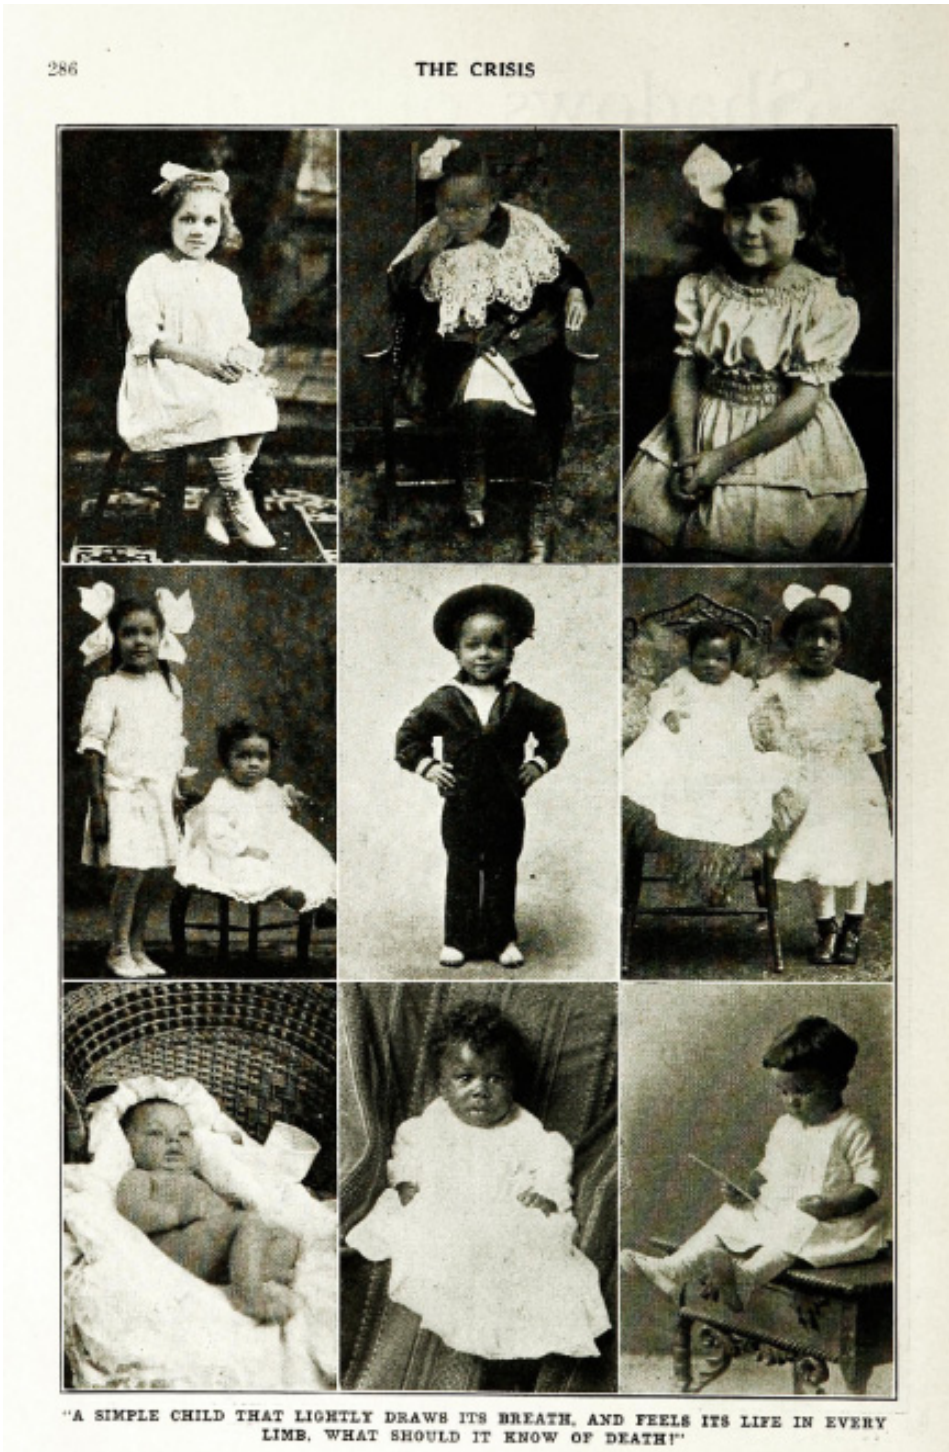
Figure 1. Sample pages from the 1916 Children’s Number’s “Shadows of Light” column, a recurring section that features numerous such grids of photographs of children. ( The Crisis 1916, 12.6, pp. 285– 86), The Modernist Journals Project, https://modjourn.org/issue/bdr510140/, (accessed on 4 Decem- ber 2018).